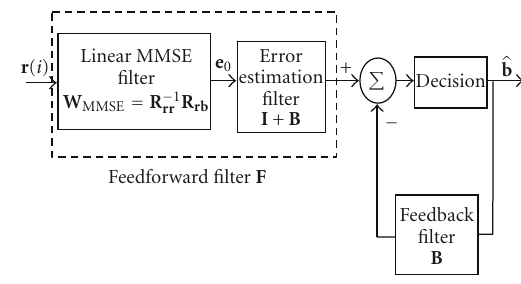
Figure 2: Block diagram of the MMSE-DFD